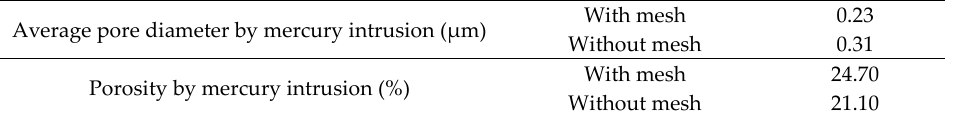
Figure 12. Porosimetry properties obtained by mercury intrusion of hydraulic lime mortar applied to natural stone substrate, with and without mesh. Table 11. Hydraulic lime mortars–capillary pores–cumulative mercury intrusion.